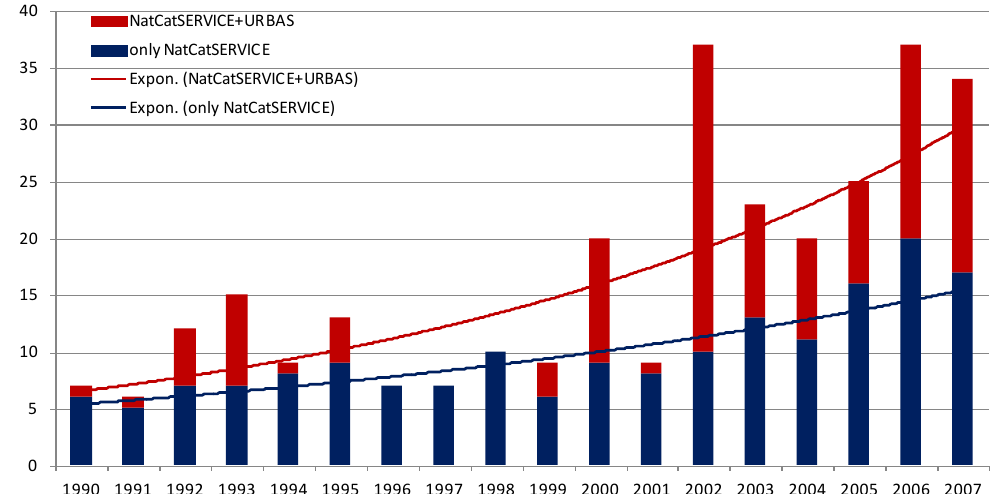
Fig. 6. Number of urban floods in Germany from 1990–2007 estimated from URBAS and NatCatSERVICE data with Figure 6. Number of urban floods in Germany from 1990–2007 estimated from URBAS and 3 NatCatSERVICE data with trends. 4